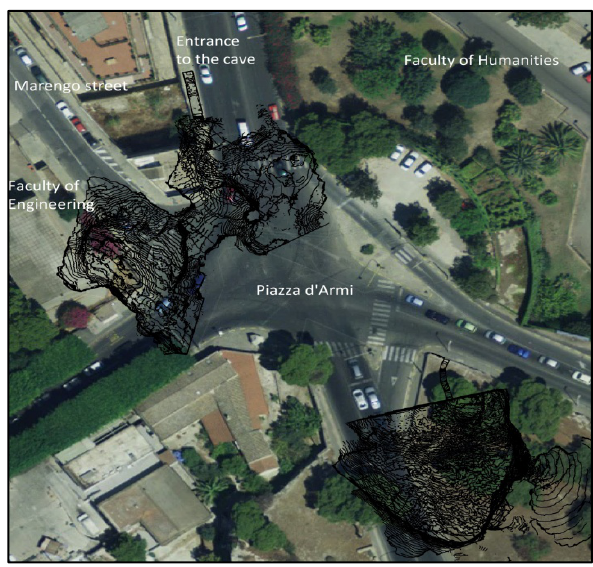
Figure 10. Contour lines of the cavities superimposed on the orthophoto at the 1:2000 scale. The cave under investigation is on the north-west side, while the great cave ‘Su Stiddiu’ is on the south-east side of the picture. The boundaries of both caves are uncertain due to the impossibility to explore some